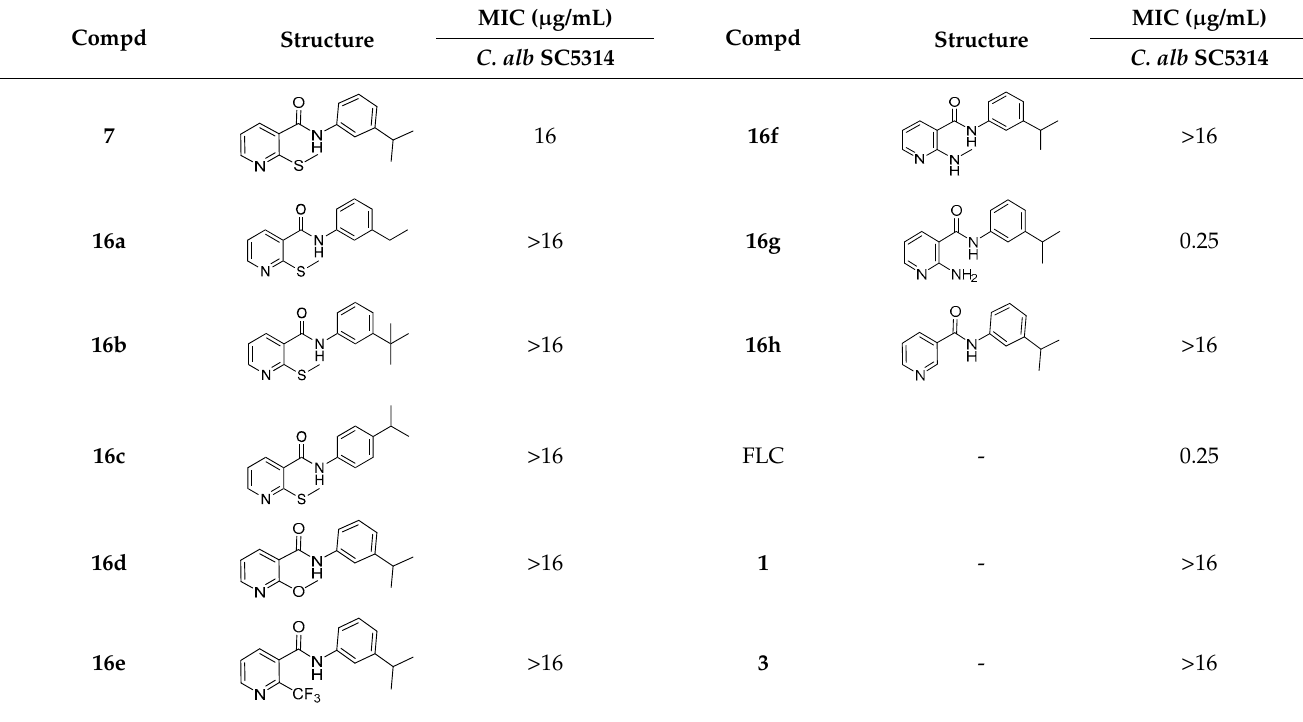
Table 1. In vitro antifungal activities of nicotinamide derivatives against C. albicans SC5314.